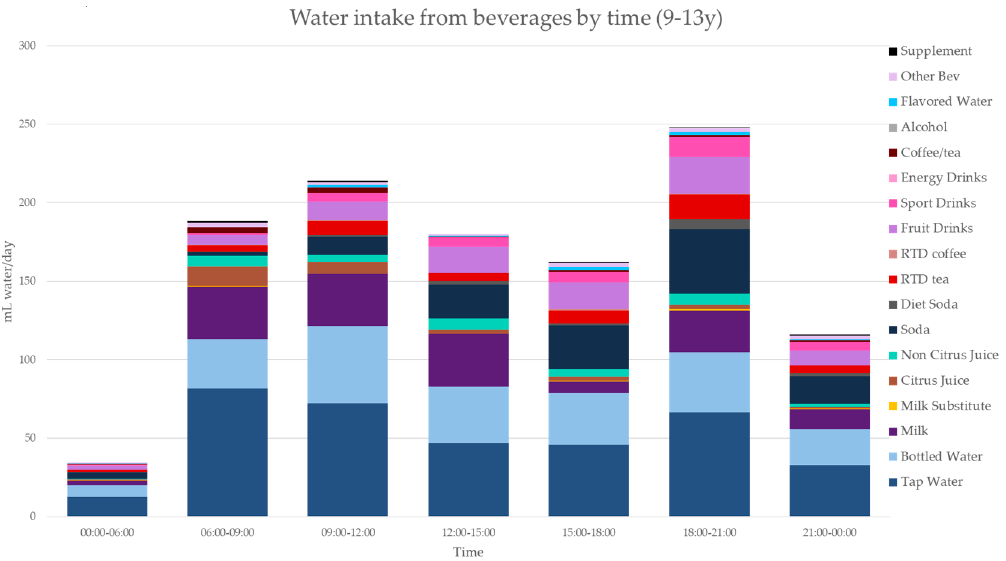
Figure 4. Water intakes (mL / d) by beverage type and time of day for the 9–13 y age group (NHANES 2011–2016).